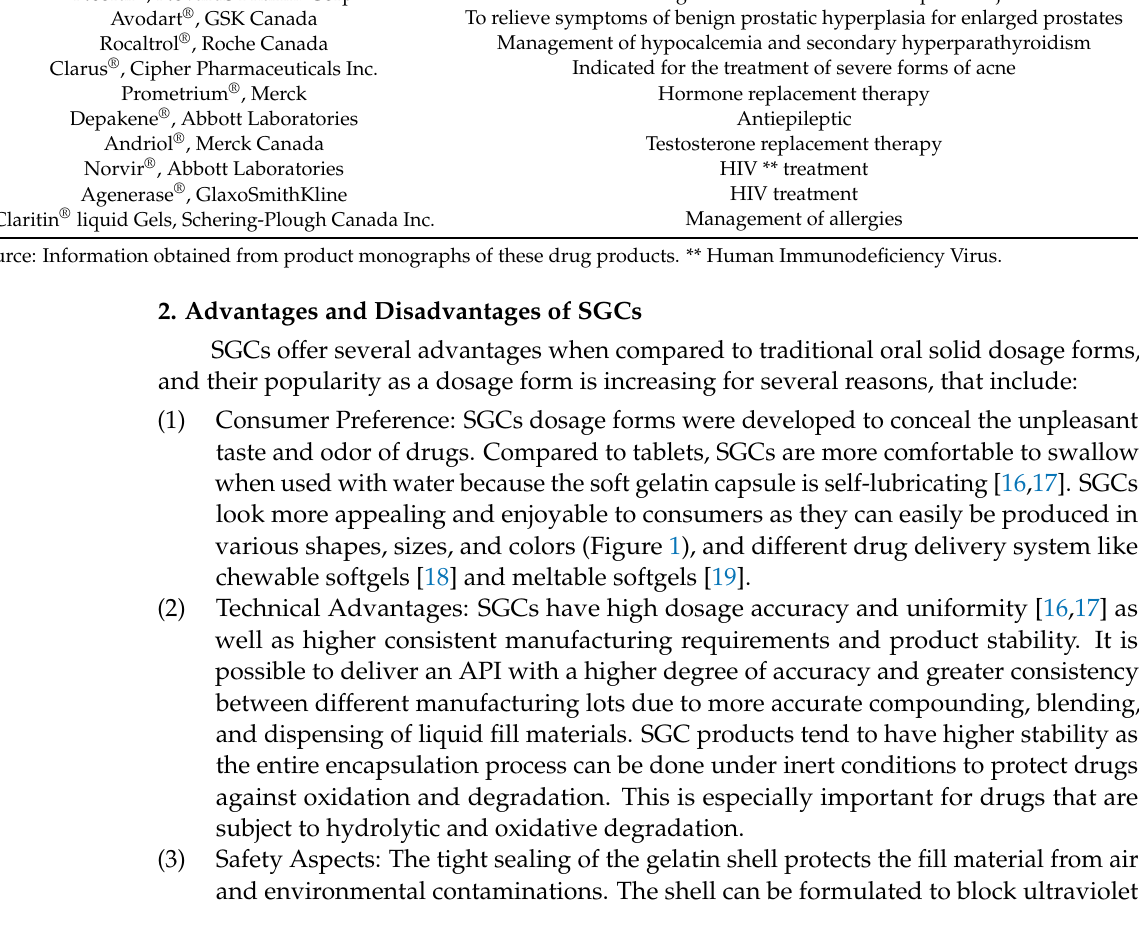
Table 1. Examples of commercially available drug products* formulated in the form of soft gelatin capsules (SGCs). Drug Brand and Company Common Uses Cyclosporine Neoral ® , Novartis Pharm.